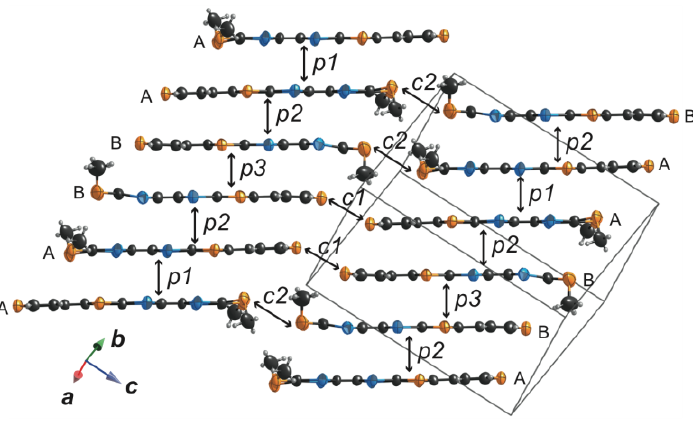
Figure 12. Donor sheet structure of (TM-TPDS-STP)PF molecular short axis. The calculated intermolecular overlaps between HOMO-1s (× 10 −3 ) are p1 = 15.7, p2 = 20.2, p3 = 12.6, c1 = −2.0, and c2 =